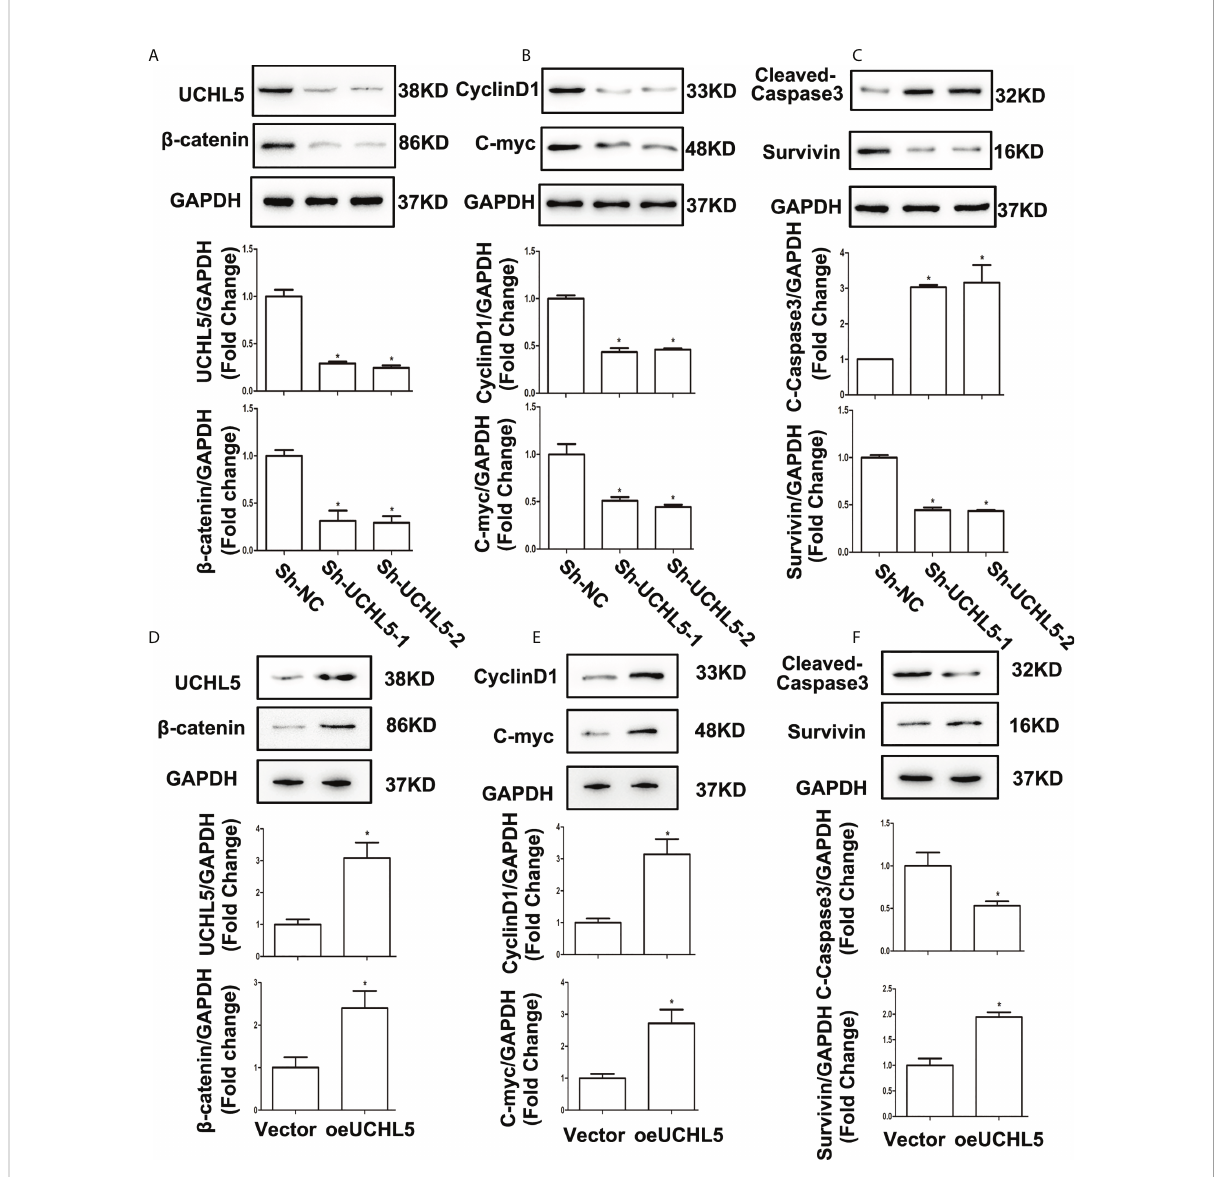
FIGURE 5 UCHL5 activated Wnt/ b -catenin signaling and affected the expression of its target genes. (A) Relative protein levels of UCHL5 and b -catenin were detected by WB in HCE-1-A cells at 48 h after shRNA lentiviral infection ( N = 3 times). * P < 0.05 vs. sh-NC. (B) Relative levels of cell cycle – related protein CyclinD1 and cell proliferation-related protein C-myc. ( N = 3 times). * P < 0.05 vs. sh-NC. (C) Relative levels of cell apoptosis-related protein cleaved-caspase3 and anti-apoptosis protein Survivin ( N = 3 times). * P < 0.05 vs. sh-NC. (D) Relative protein levels of UCHL5 and b -catenin were detected by WB in AN3-CA cells at 48 h after infected with overexpressed lentiviral vectors ( N = 3 times). * P < 0.05 vs. empty vector. (E) Relative levels of CyclinD1 and C-myc ( N = 3 times). * P < 0.05 vs. empty vector. (F) Relative levels of cleavedcaspase3 and Survivin ( N = 3 times). * P < 0.05 vs. empty